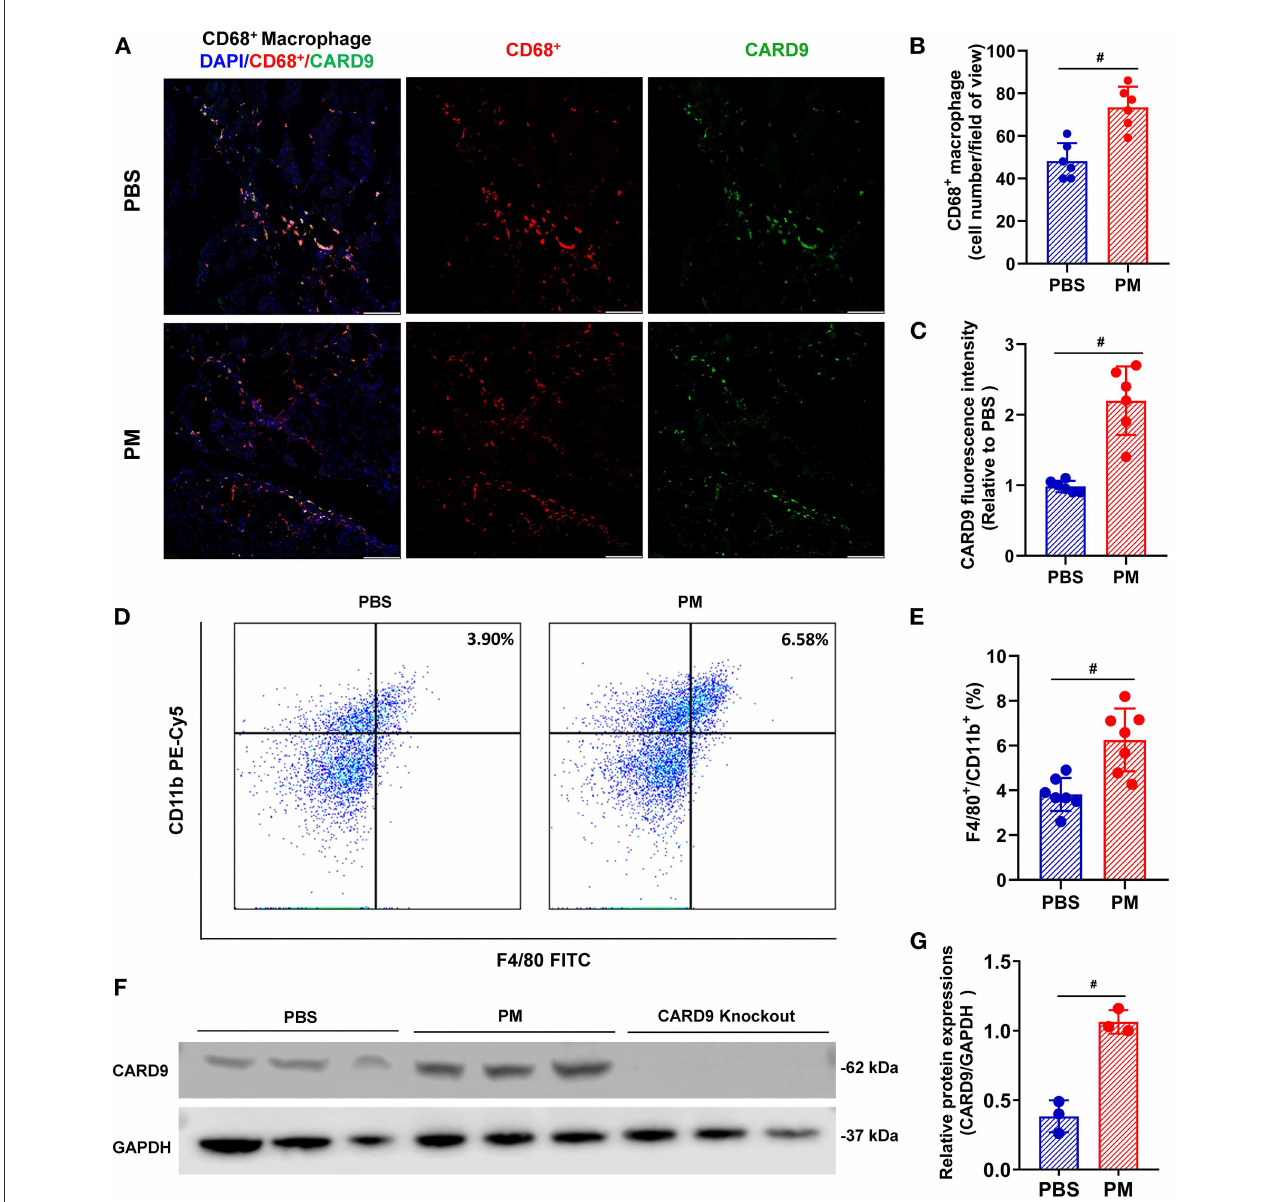
FIGURE3 PM exposure increased the numbers of macrophages in blood and ischemic limbs and CARD9 protein level in ischemic limbs. CD68 + macrophage infiltration in ischemic limbs was evaluated using immunostaining assay and circulating CD11b + / F4/80 + monocytes/macrophages were examined by flow cytometry. As demonstrated in (A, B, D, E) , PM treatment significantly increased the levels of CD11b + /F4/80 + cells in blood and CD68 + macrophages infiltration in the ischemic limb compared to PBS-treated control ( # p < 0.01, n = 6). Immunostaining and western blot assays showed that CARD9 protein level was significantly increased in the ischemic limb in PM-treated mice compared to PBS-treated controls [ # p < 0.01, n = 6, (A, C, F, G) ]. DAPI, 4,6-diamidino-2-phenylindole; Scale bar, 50 µ m. Statistical differences were determined with Student’s two-tailed